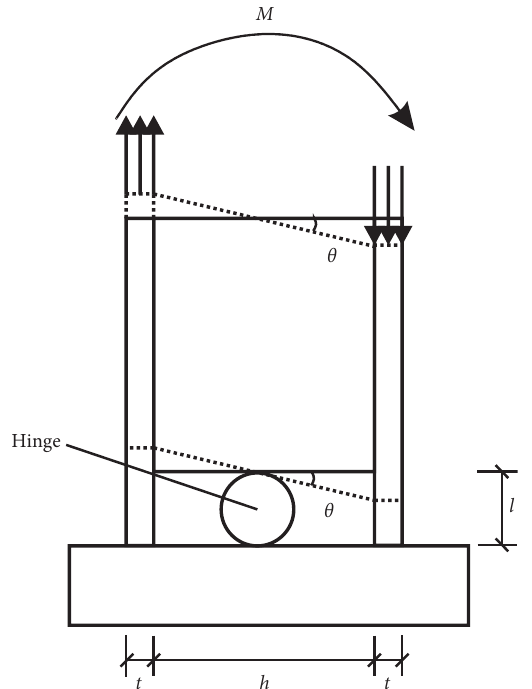
Figure 5: The elastic deformation of the energy-dissipation